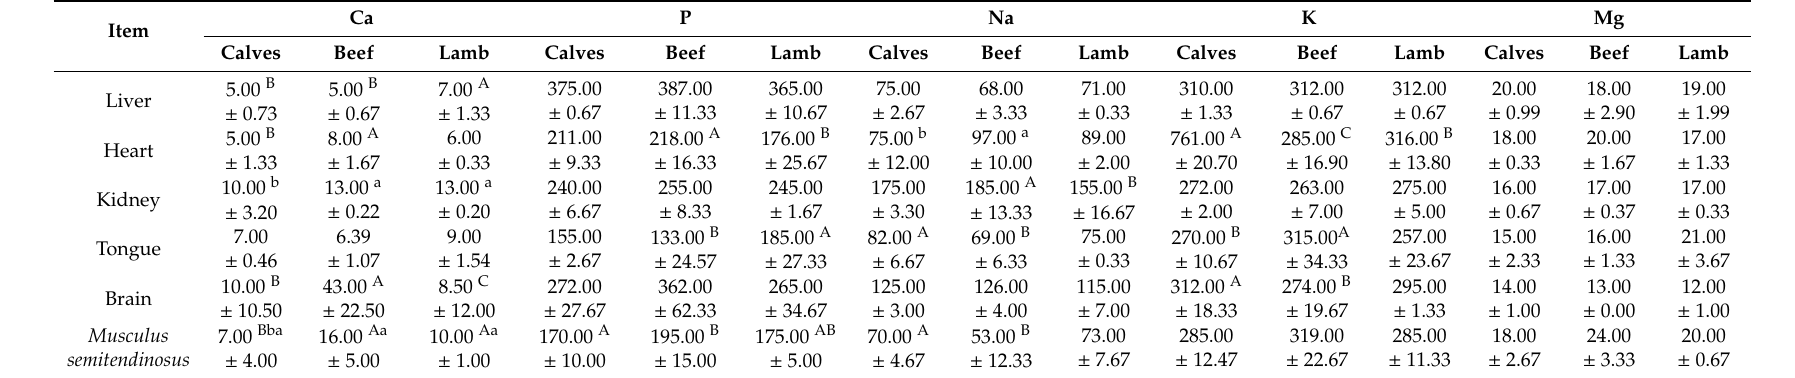
Table 2. Macronutrients in the tested organs (mg / 100